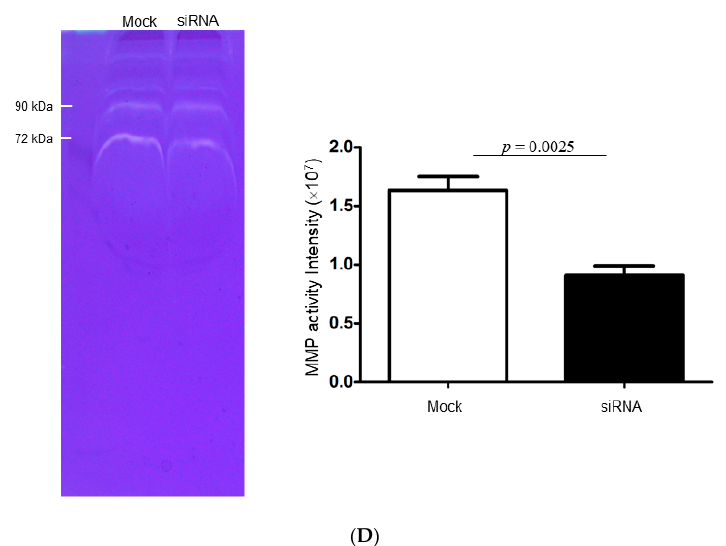
Figure 4. ( A ) Confirmation of changes in protein expression under RNA interference-mediated silencing of cathepsin D treatment. Protein levels of cathepsin D, ER and HER2 were assessed by the Western blot analysis. The intensity was calculated using the Image Pro-Plus 4.5 computer program and indicated by the bar chart. ( B ) The levels of cathepsin D -modulated EMT associated proteins including ZO-1 and N-cadherin were evaluated by the Western blot analysis. The quantified results were demonstrated by the bar chart (** p < 0.01; *** p < 0.001) and β -actin was utilized as a loading control. ( C ) PVDF membrane stained with Coomassie blue R-250 was applied to visualize loading amount of proteins (left panel) and validation of changes in protein expression in condition medium samples after RNA interference-mediated silencing of cathepsin D (right panel). ( D ) Gelatin zymography was performed with condition media of ZR-75-1 cells with or without silencing cathepsin D transfection. Relative matrix metalloproteinases (MMPs) were quantified and presented as bar charts. The students’ t -test was applied for comparison between 2 groups compared to the mock.